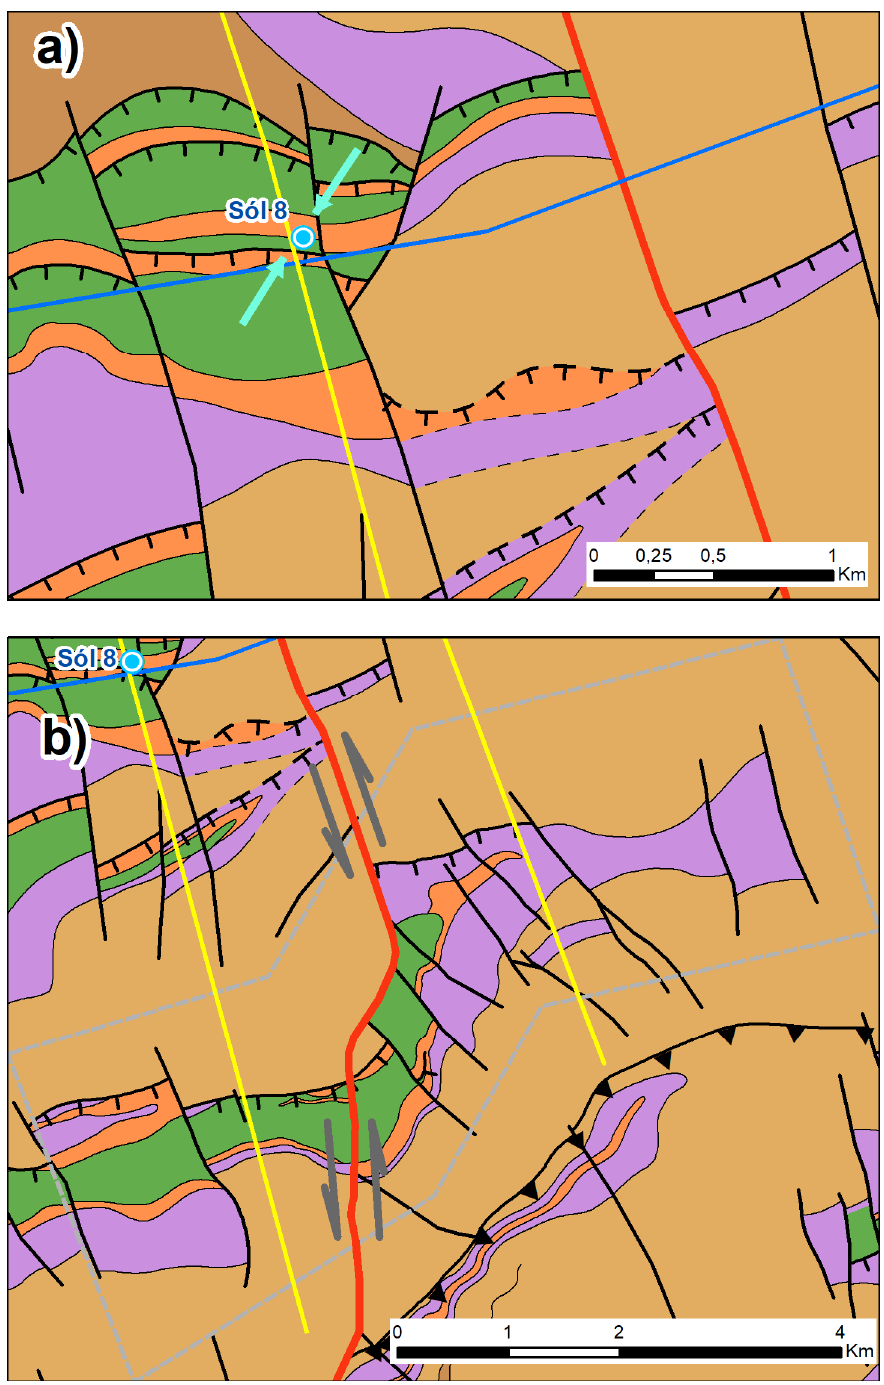
Figure 4. ( a ) Location of the Sól-8 borehole with the approximate direction of the Sh max after Jarosi ń ski marked by arrows, ( b ) bending of the anticline axis indicating sinistral displacement on the Rycerka Fault.